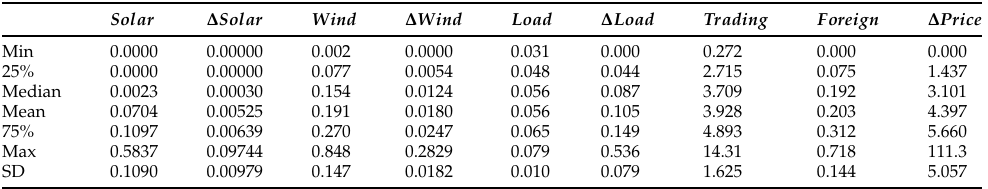
Table 2. Descriptive statistics of the explanatory variables. Solar is the relative solar share of the total consumption, and ∆ Solar is the relative solar forecast error of the total consumption. Wind and ∆ Wind are analogously defined as the relative wind share and the relative wind forecast error of the total consumption. Load is the volume of the total consumption in TWh, ∆ Load is the unsigned relative excess generation over consumption in Germany, Trading is the traded volume of the intraday market in GWh, Foreign is the relative share of the volume (buy and sell) traded between Germany and a foreign country and the total traded volume of the intraday market, and ∆ Price is the absolute price difference of the day-ahead auction price and the volume-weighted average intraday price.